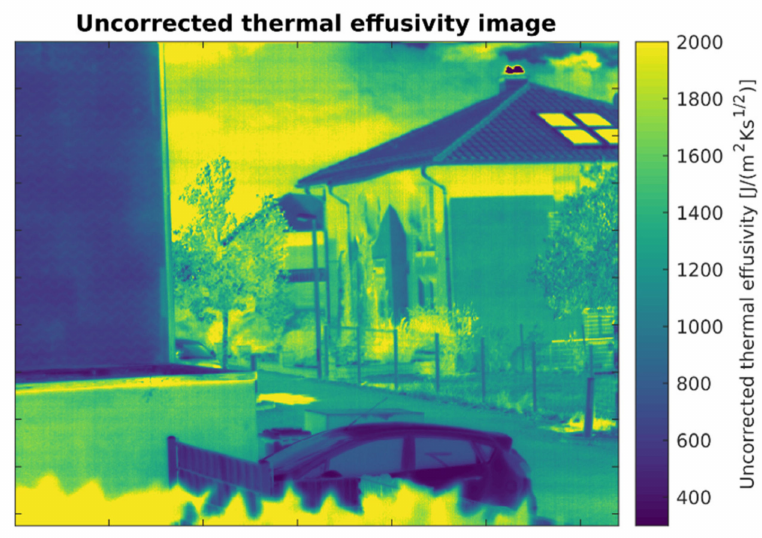
Figure 6. Effusivity image resulting from the SHT approach.